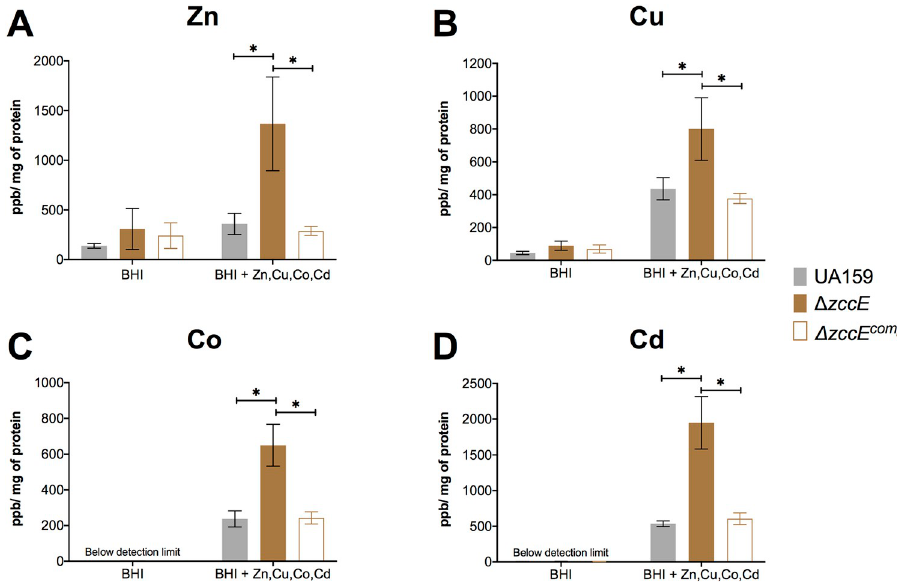
Fig 8. ICP-MS quantifications of intracellular Zn, Cu, Co, and Cd in UA159, Δ zccE , and complemented strains. Strains were grown in BHI to mid-exponential phase at which point the experimental groups were exposed to a mixture of sub-inhibitory concentrations of the 4 metals (0.5 mM Zn, 0.5 mM Cu, 0.5 mM Co and 2.5 μ M Cd) for 90 minutes. The graphs indicate intracellular parts per billion of Zn (A), Cu (B), Co (C) and Cd (D) normalized by milligram of total protein. Two-way ANOVA was used to determine significant differences in intracellular metal content among strains after metal exposure. A p value of < 0.05 was considered significant ( � ). Average and error bars represent standard deviations of results from at least 3 independent experiments.